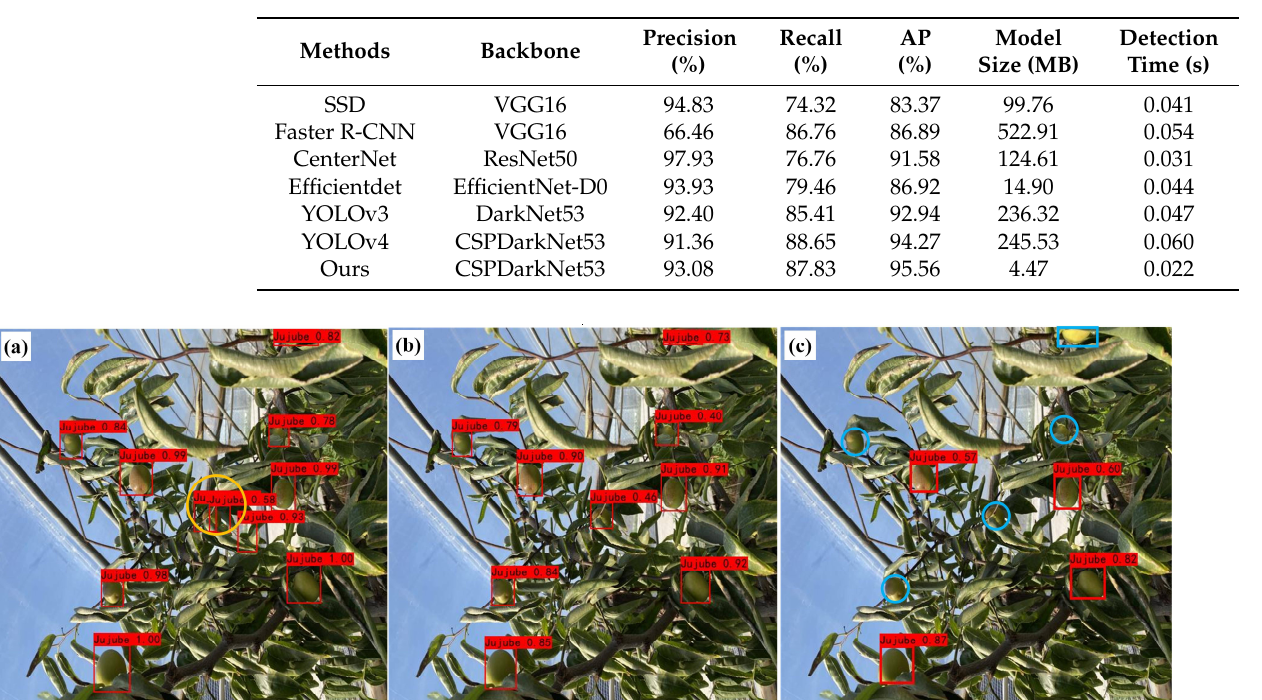
Table 1. Detection results with different object detection networks.